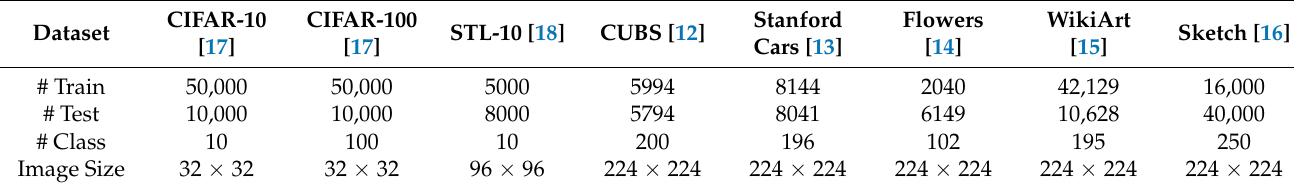
Table 2. Datasets used for experiments.